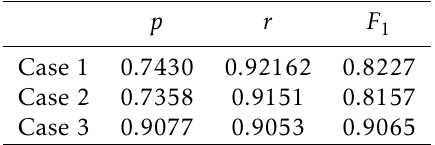
Table 1. Results obtained for the three cases of study.